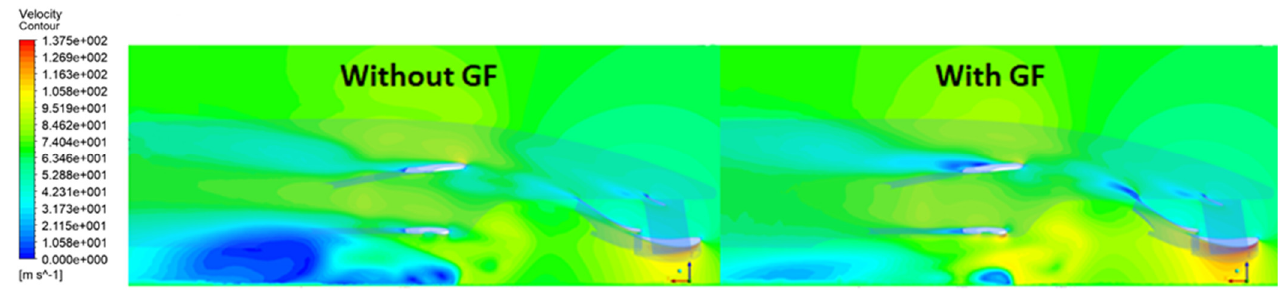
Figure 12. Comparison on the y 4 plane of velocity contours between the case with and without GF.